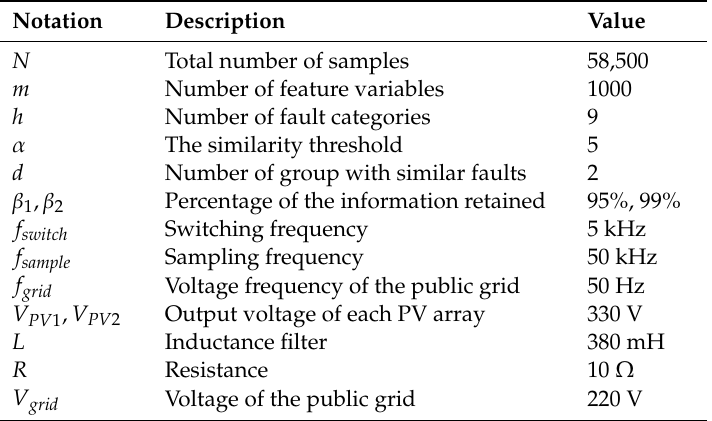
Table 2. Main parameters of the fault diagnosis strategy.